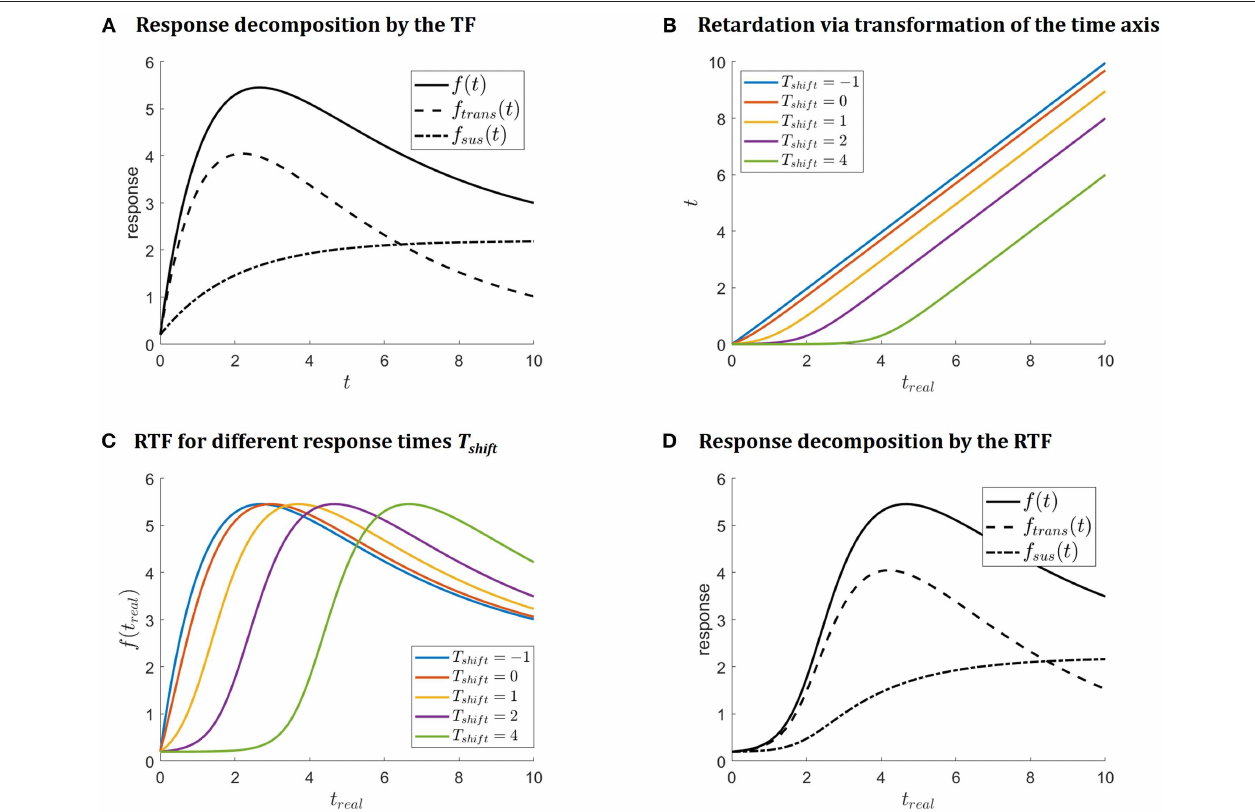
FIGURE 1 | (A) Illustrates decomposition of the response function (4) into sustained f sus and transient f trans parts. (B) Illustrates the transformation of the time axis which is introduced to retard the response curve. The impact on the response function is depicted in (C) . Decomposition of the retarded response function f ( t real ) f sus ( t real ) f trans ( t real ) is shown in (D) for T shift = + =